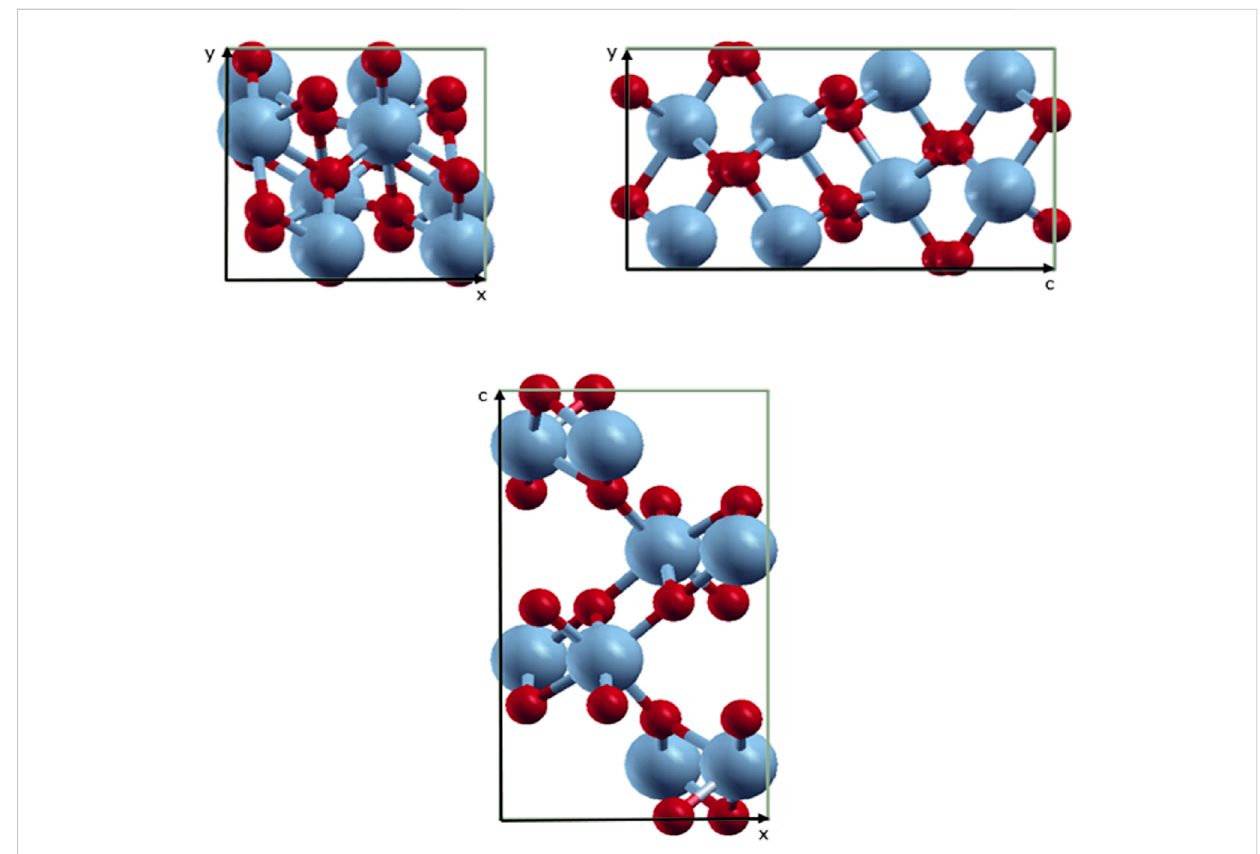
FIGURE 1 Schematic representations of the VO 2 (M) unit cell. Color code in the ball and stick model: V = blue and O = red.